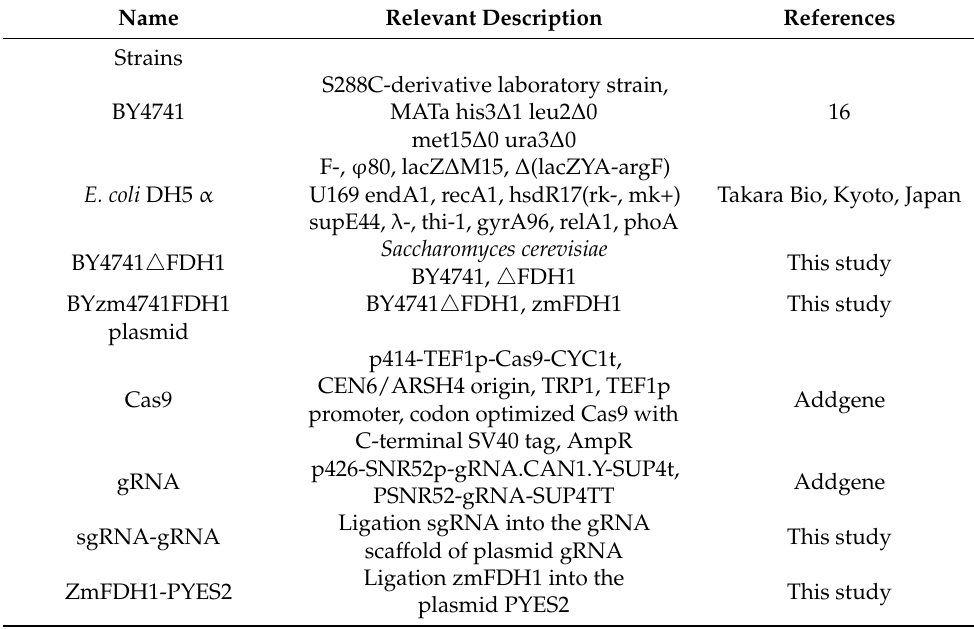
Table 2. Strains and plasmids used throughout the